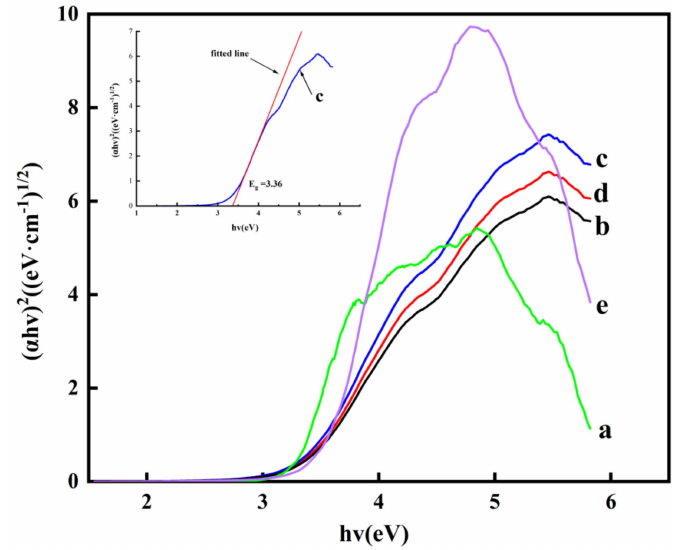
Figure 5. Tauc plots of pure ZSM-5 ( a ) and composite products with different Zn/Si ratios Zn–ZSM5 n(Zn)/n(Si) of: ( b ) 1:200; ( c ) 1:100; ( d ) 1:50; ( e ) 1:25. The determinations of Eg for measurements c are shown as